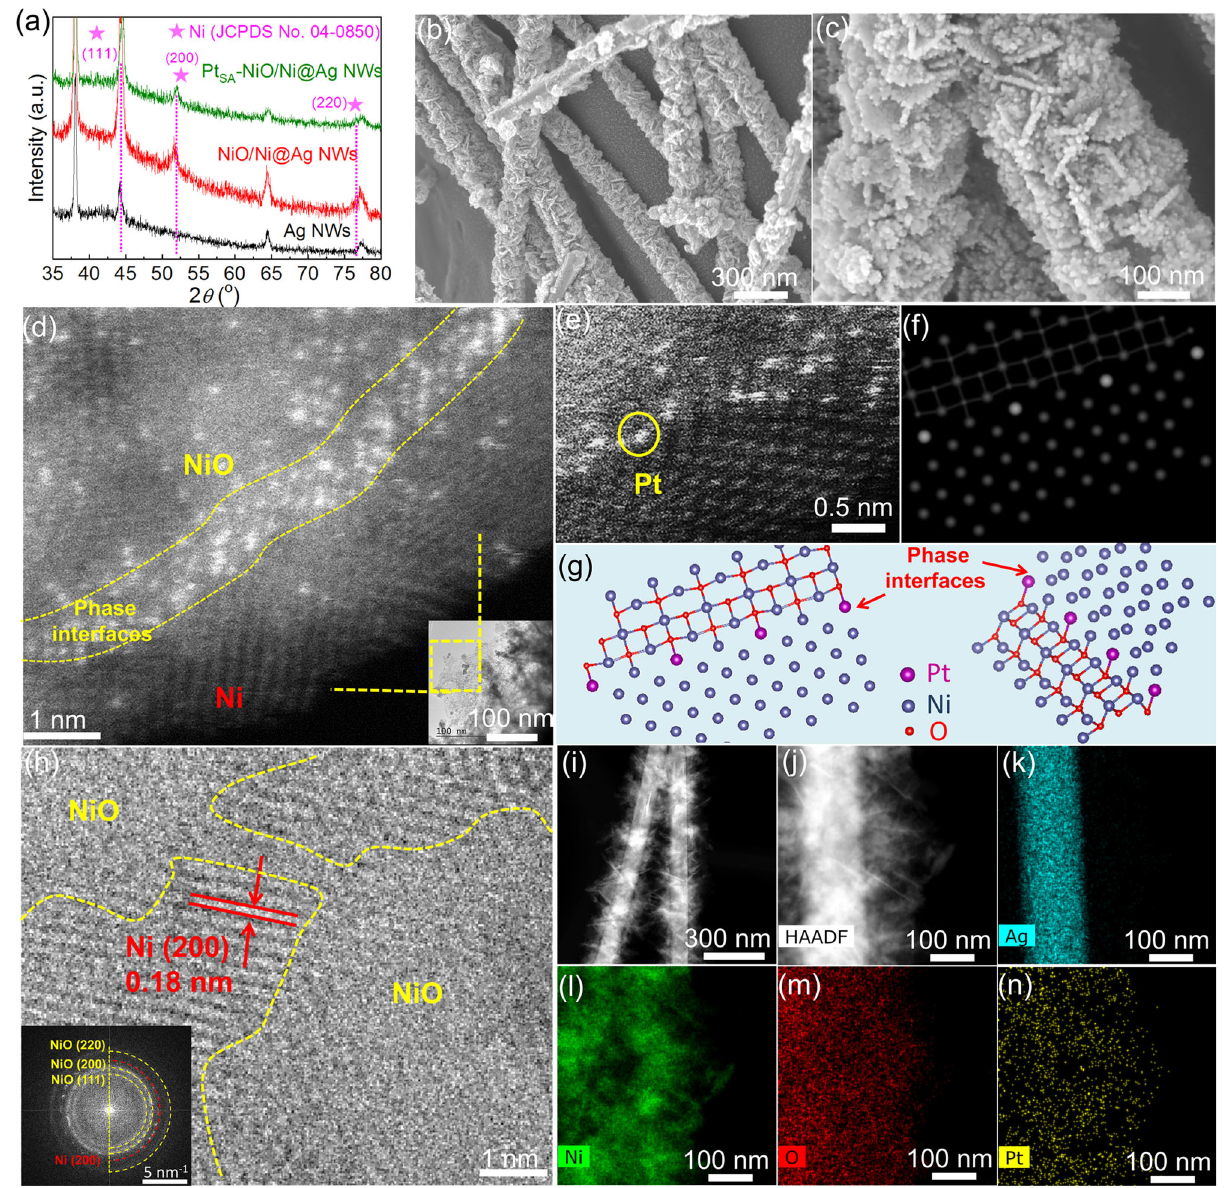
Fig. 2 Structural characterization of the fabricated Pt SA -NiO/Ni catalyst. a XRD patterns of Pt SA -NiO/Ni, NiO/Ni, and Ag NWs. b, c SEM images of Pt SA - NiO/Ni. d HAADF-STEM image of Pt SA -NiO/Ni. e Magni fi ed HAADF-STEM image of Pt SA -NiO/Ni and f, g the illustrated interface structure by DFT calculation, showing the atomically dispersed Pt atoms at Ni position (circles in ( e )). h HRTEM images of Pt SA -NiO/Ni and the insert in ( h ) show the related FFT pattern of Pt SA -NiO/Ni. i, j HAADF-STEM images of Pt SA -NiO/Ni at different magni fi cations and k – n the elemental mapping of the corresponding